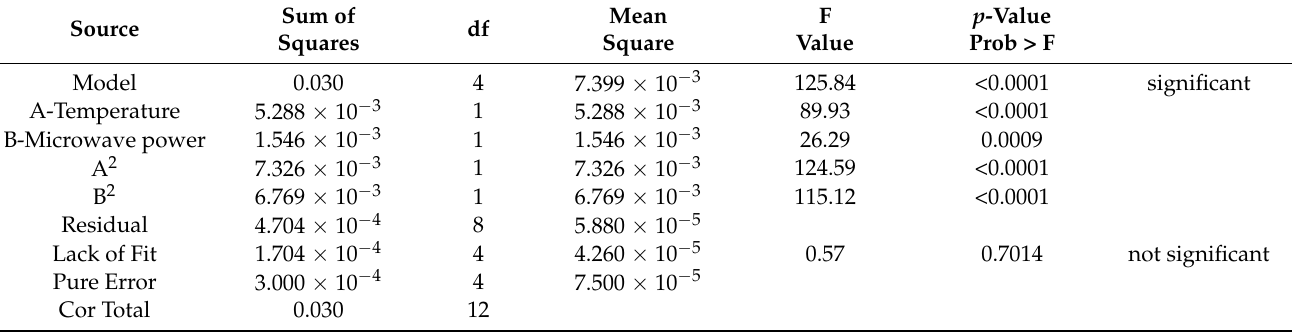
Table 10. Analysis of variance for RR using RSM.